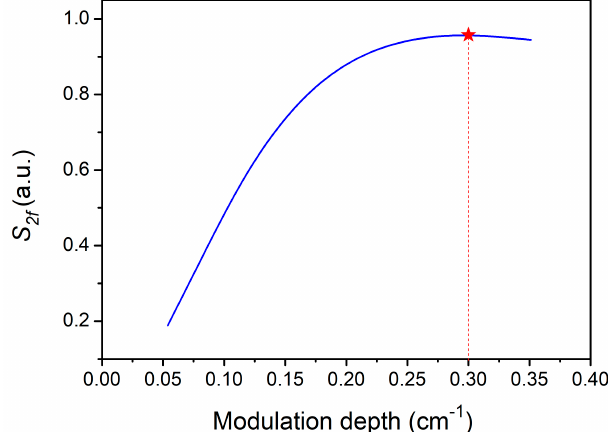
Figure 4. Second harmonic signal S 2f as a function of modulation depth.